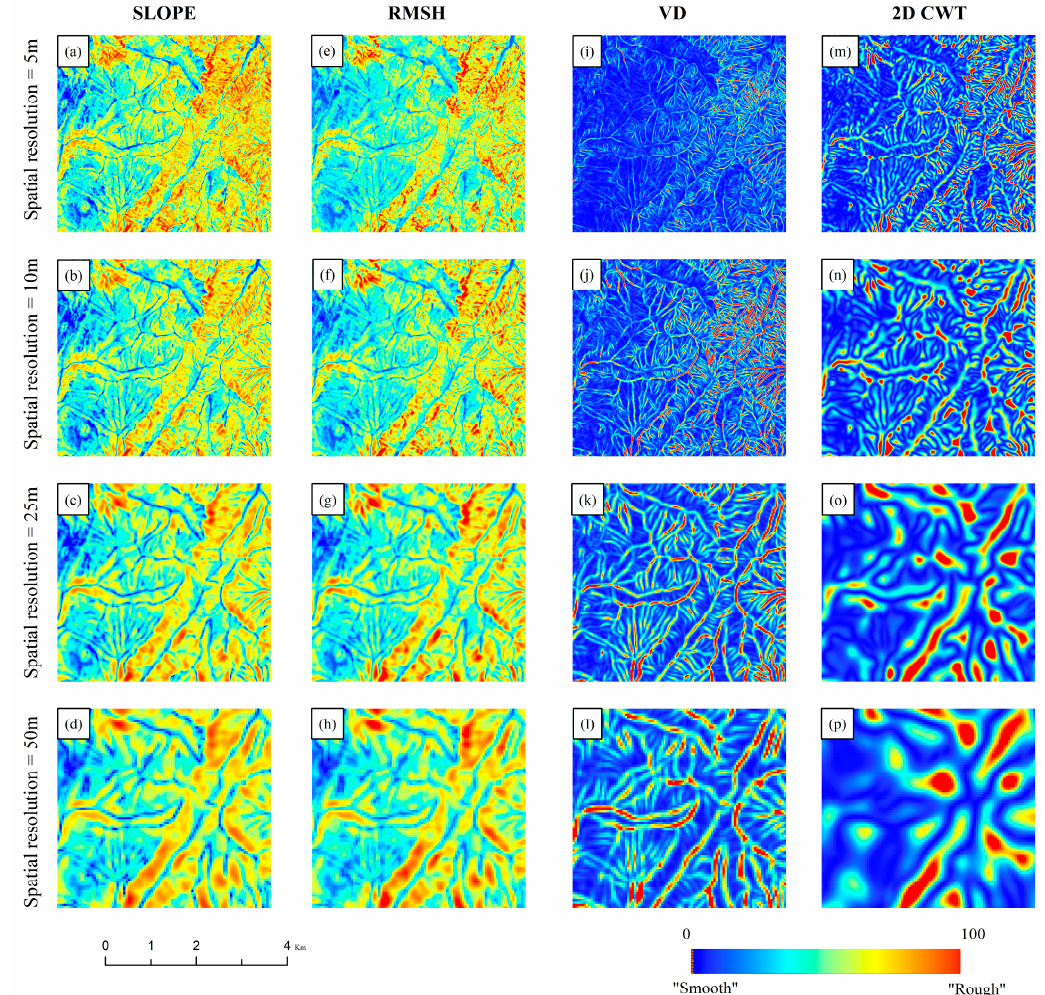
Figure 3. Extraction results of the different roughness algorithms with different resolutions (mountainous region).